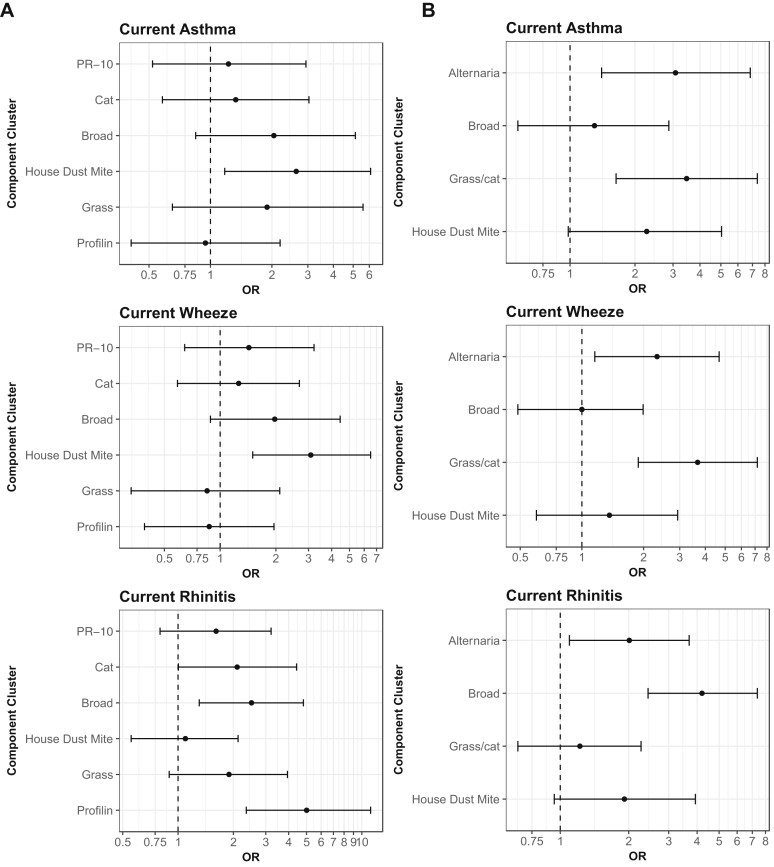
ORs and 95% CIs from multiple logistic regression, for asthma and rhinitis at age 16 years based on subjects' reduced responses to (A) component clusters at age 16 and (B) component clusters at age 5 years.